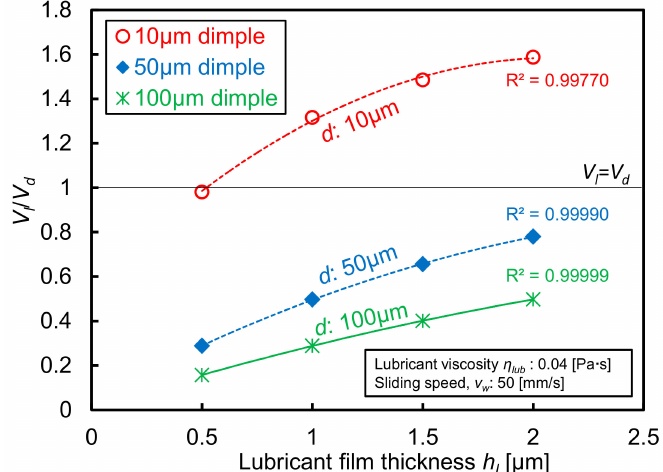
Figure 13. Variations of the relative volume V l / V d as a function of the lubricant film thickness h l for di ff erent dimple diameters of 10 µ m, 50 µ m, and 100 µ m. Dotted lines are quadratic approximated lines for the data of each dimple